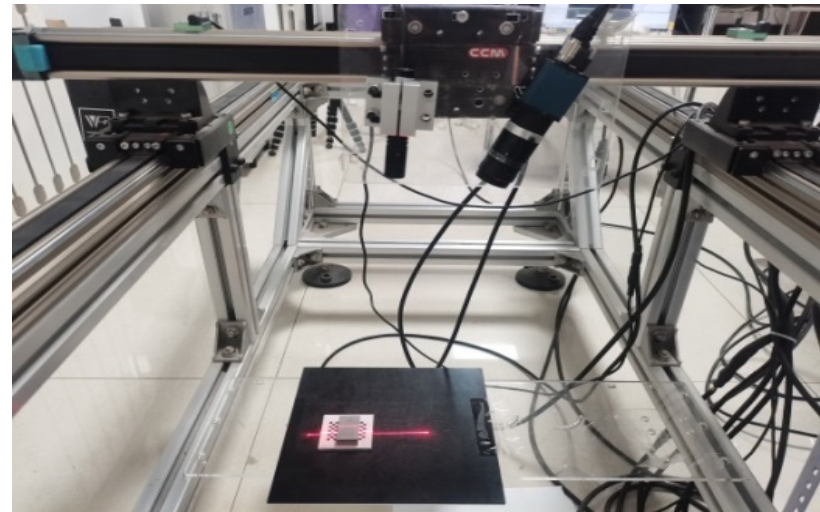
Figure 11. Experimental platform diagram.